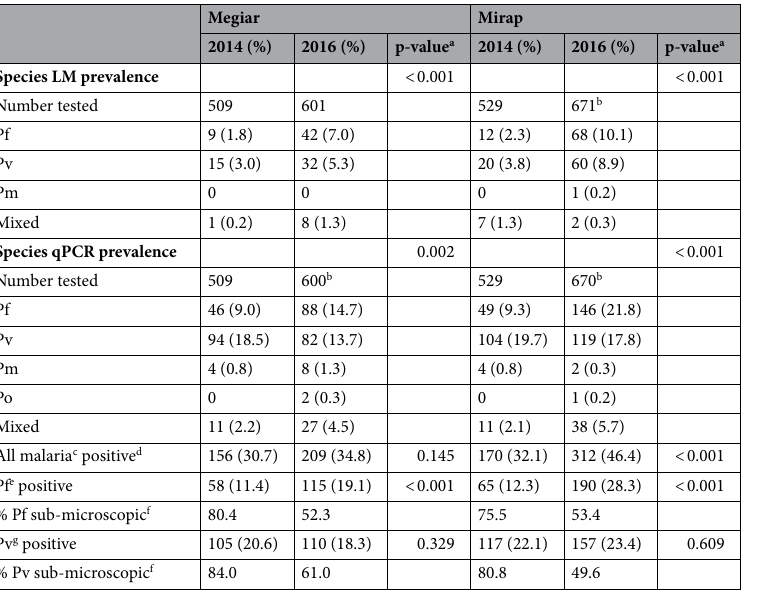
Table 1. Prevalence of Plasmodium spp. infection by light microscopy and polymerase chain reaction in Megiar and Mirap in 2014 and 2016. LM light-microscopy detected, qPCR PCR detected, Pf P. falciparum , Pv P. vivax , Pm P. malariae , Po P. ovale. a p-value based on chi-square test comparing prevalence between 2014